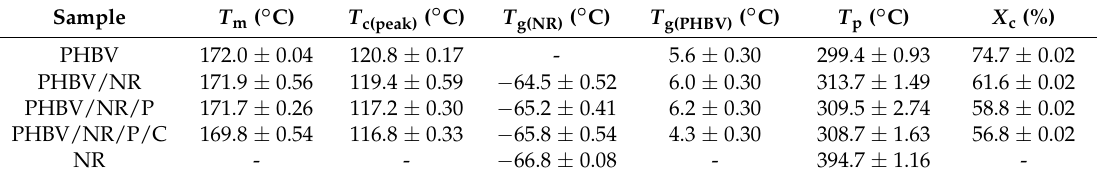
PHBV/NR/P/C The column headings are T m , melting temperature; T c(peak) , peak crystallization temperature; T g(NR) , glass transition temperature corresponding to NR component; T g(PHBV) , glass transition temperature corresponding to PHBV component; T p , peak thermal degradation temperature; and X c , degree of